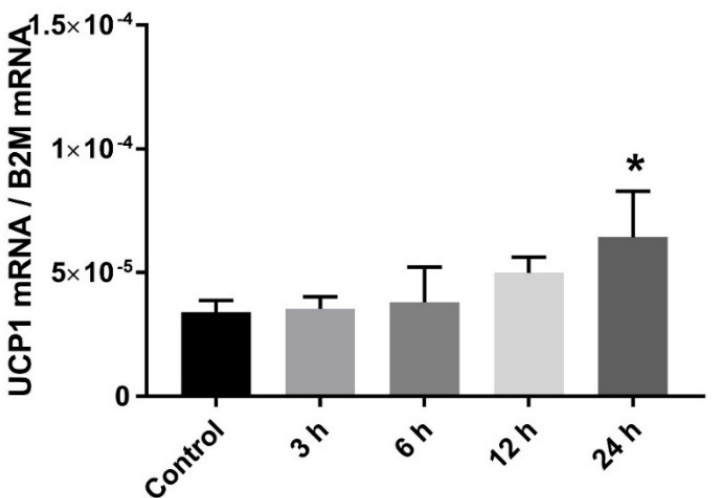
Figure 3. Relative expression of UCP1 in raccoon dog adipocytes ( n = 4) with 10 µ mol/L isoprenaline for different time periods (3 h, 6 h, 12 h, and 24 h). Control adipocytes were treated with PBS. UCP1 expressions are normalized to the expression of beta-2 microglobulin ( B2M) and the result values are presented as mean ± SD. Statistically significant difference is indicated by * p < 0.05.